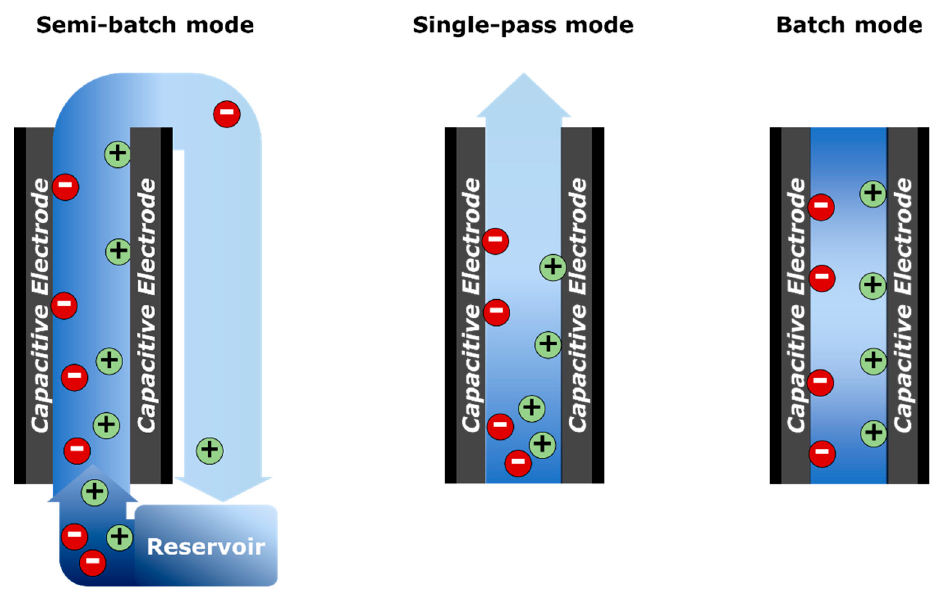
Figure 2. Conditions for flowing the feed solutions: Semi-batch, single-pass, and batch modes.